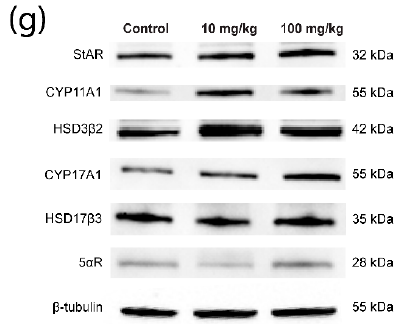
Figure 3. Persistent effects of five weeks oral DBP exposure on testis steroidogenic enzymes in adult mice. Levels of StAR ( a ), CYP11A1 ( b ), HSD3 β 2 ( c ), CYP17A1 ( d ), HSD17 β B3 ( e ), and 5 α R ( f ) were measured by Western blot in mouse testis collected one week after the last DBP administration. Values represent mean ± S.D. from 12 animals per group. Representative blots of three experiments are shown ( g ). β -tubulin was used as a loading control. StAR = steroidogenic acute regulator, HSD = hydroxysteroid dehydrogenase, 5 α R = 5 α -reductase. Statistically significant differences from control are indicated as follows: * p < 0.05, ** p < 0.01 (One-way ANOVA followed by Dunnet’s test). Furthermore, we evaluated the oxidative stress protein-damage marker nitrotyrosine groups treated with DBP, compared with the control group (Figure 4).